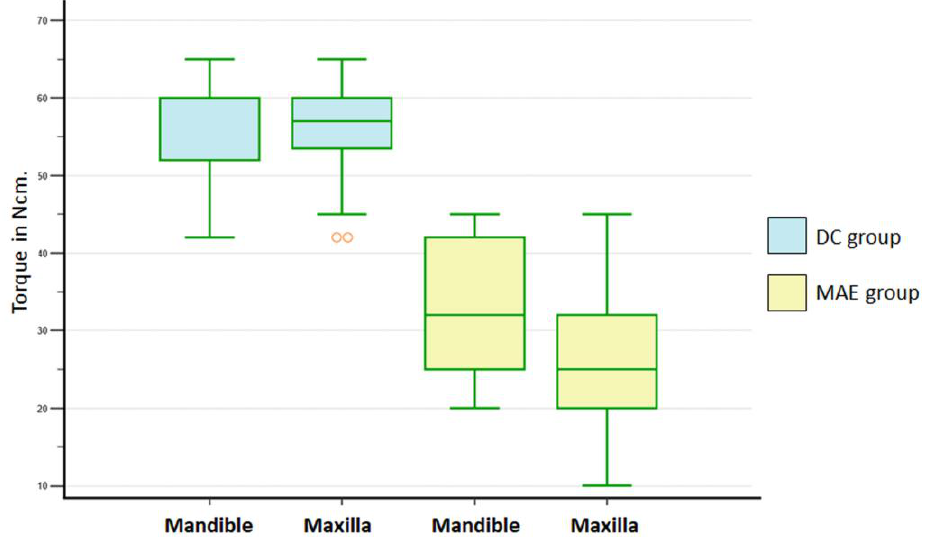
Figure 3. Box-plots graph (1st, 2nd, Median, 3rd, 4th quartiles) of ITV for DC and MAE groups within each arch. Outlier values are indicated in orange.